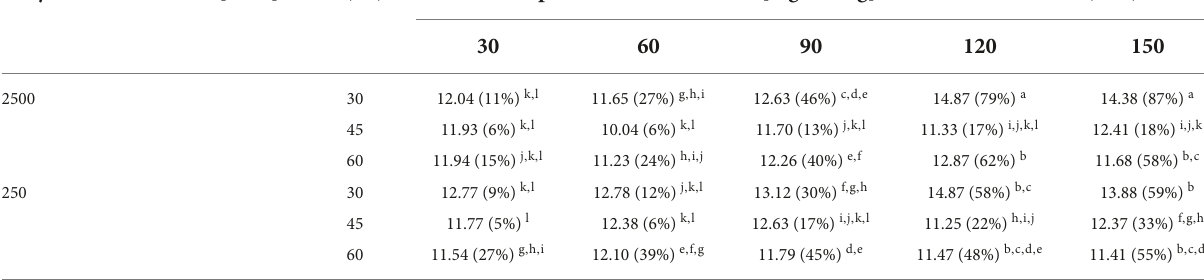
TABLE 1 Total phenolic concentration in chili pepper seed (CPS) extracts obtained at different time periods, temperatures, and cellulase concentrations. Enzyme concentration [UI/L]